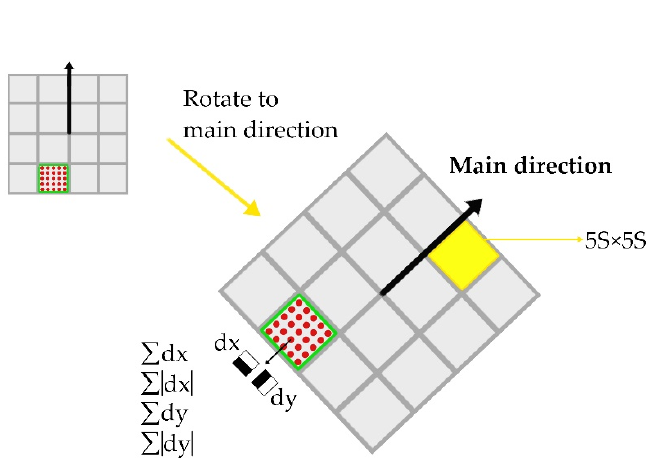
Figure 9. ARAC foreground feature descriptor generation. The square is rotated to coincide with the main direction.